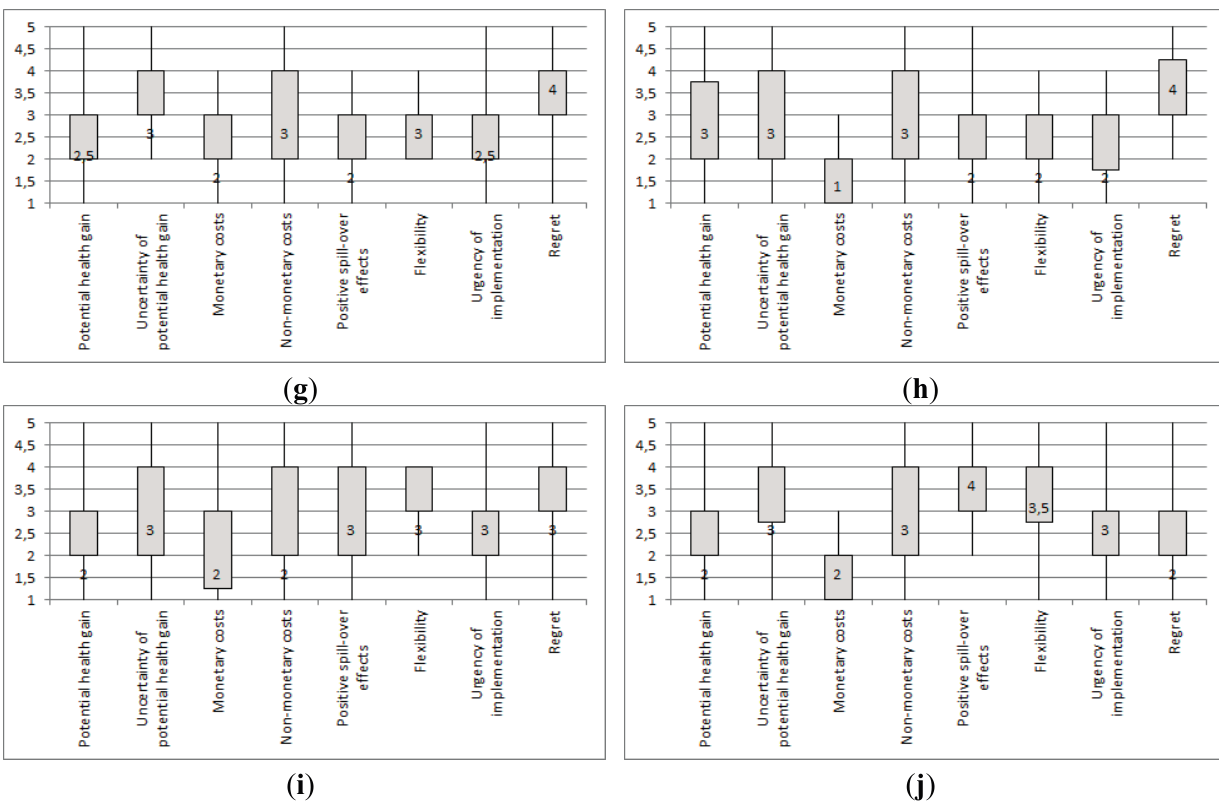
Figure 1. Box plots of the aggregate expert sample assessment of the responses to climate change-induced infectious disease risk in Western Europe, using the eight assessment criteria:( a )monitoring; ( b ) outbreak investigation and response; ( c ) dissemination of information, and health education; ( d ) fostering interagency and community partnerships; ( e ) enforcing laws and regulations; ( f ) access to health care, and prevention; ( g ) strengthening the capacity of public health workforce and implement emergency preparedness training; ( h ) research; ( i ) environmental management; and ( j ) direct control methods.Notes: Medians